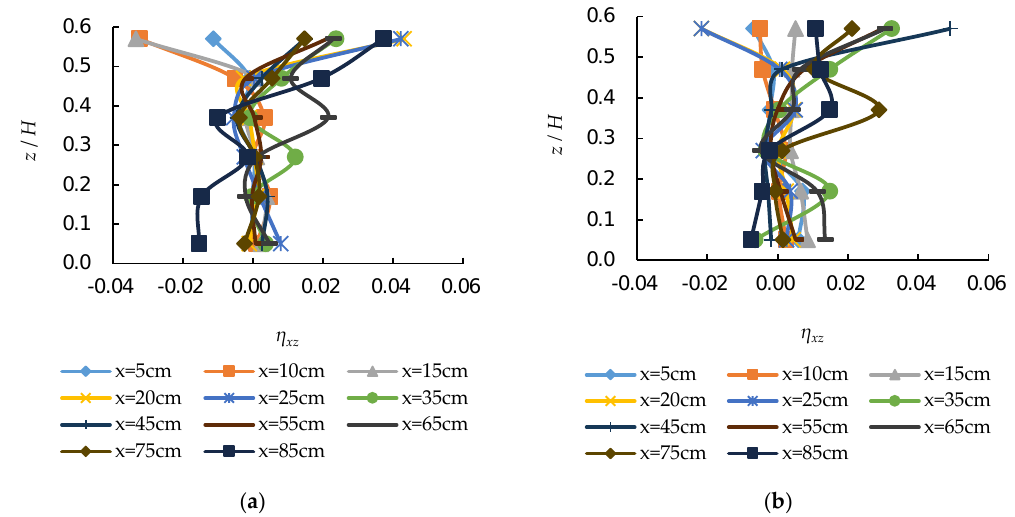
Figure 11. Vertical distribution of Reynolds stress on the xoz plane.( a ) Q 1 = 20.79 L/s; ( b ) Q 2 = 30.04 L/s.